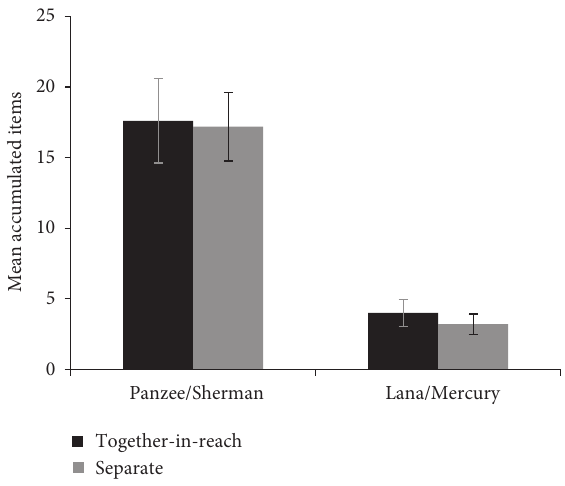
F 3: Chimpanzee performance in a joint accumulation test as a function of whether the partner animals were housed together or in separate adjacent enclosures. In both cases, chimpanzees’ accumu- lation tubes were within reach (items accumulated in the together- out-of-reach condition was out of the chimpanzees’ control). Error bars represent the Standard Error of the